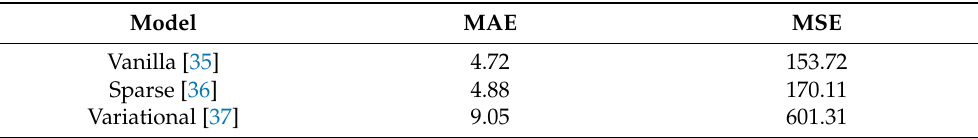
Table 1. Reconstruction errors for each AE model.